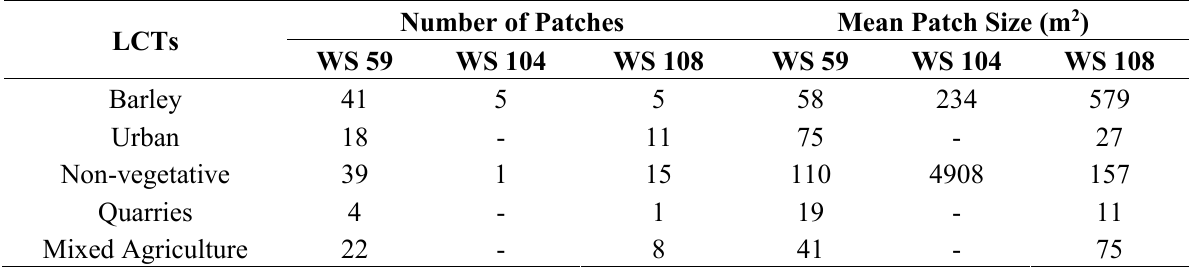
Table 5. Number of patches and mean patch size for each